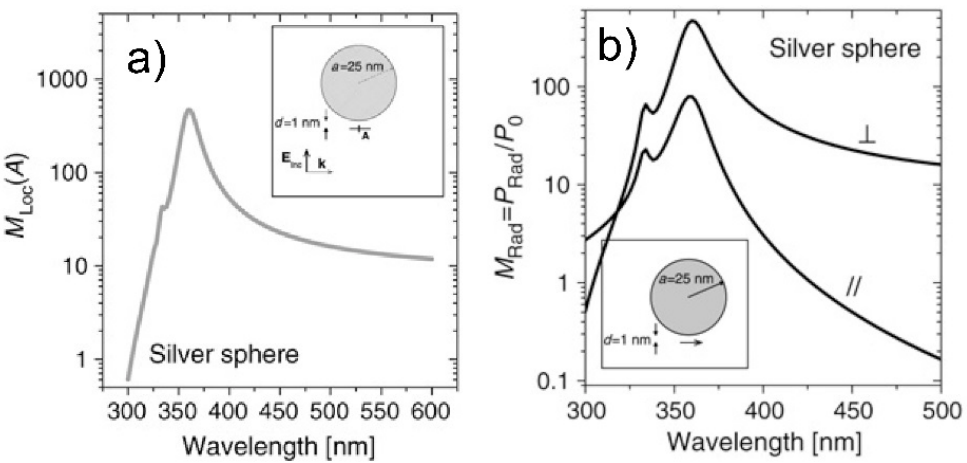
Figure 2. M Z ( M in the figure) and M Rad as a function of the wavelength are shown in panel ( a , b ), respectively. The molecule is placed 1 nm away from the surface of the silver nanoparticle (25 nm radius), along the direction in which the excitation laser is polarized ( Z ). Concerning the re-emission enhancement, M Rad is the power emitted by the dipole integrated over the whole solid angle of emission; the molecular dipole can be oriented either parallel ( ∥) or perpendicular ( ⊥) to the surface. Reproduced with permission from Le Ru et al. [6]. Copyright (2009), Elsevier B.V.